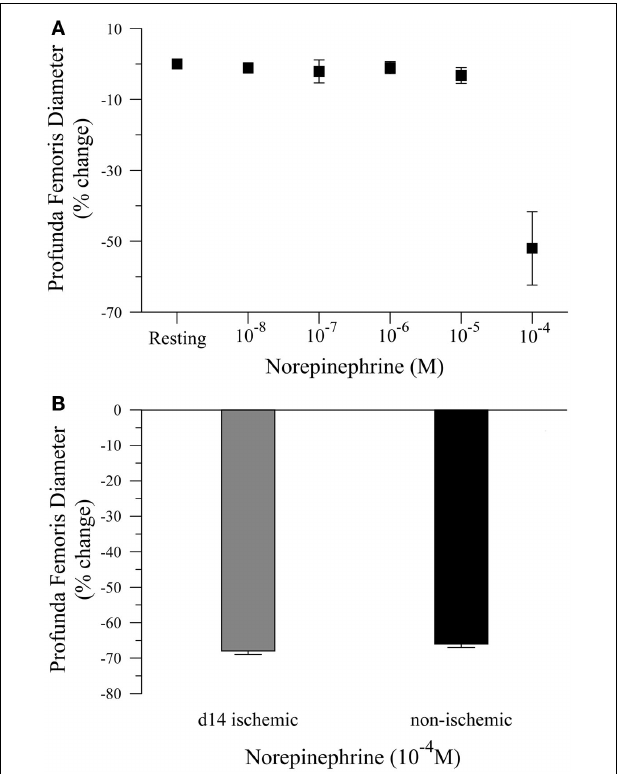
FIGURE 3 |Vasoconstriction responses to norepinephrine in ischemic and non-ischemic profunda femoris arteries, in vivo . (A) Pilot study measuring the vasoconstriction responses to increasing doses of norepinephrine (NE), applied in 10 − x M increments, and (B) vasoconstriction responses to maximal doses of NE (10 − 4 M) in day-14 ischemic (gray) and contralateral control (black) profunda femoris arteries. Data points are on a relative scale, with resting diameter represented by 0%.